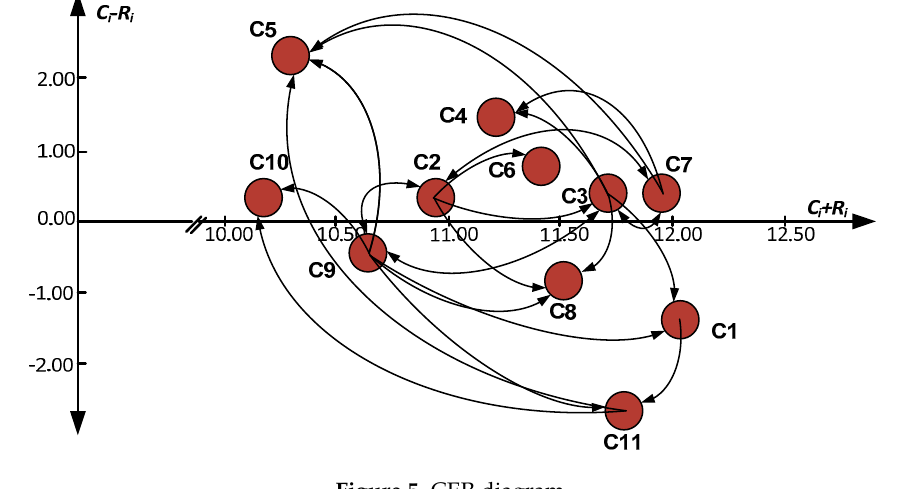
Figure 5. CER diagram.